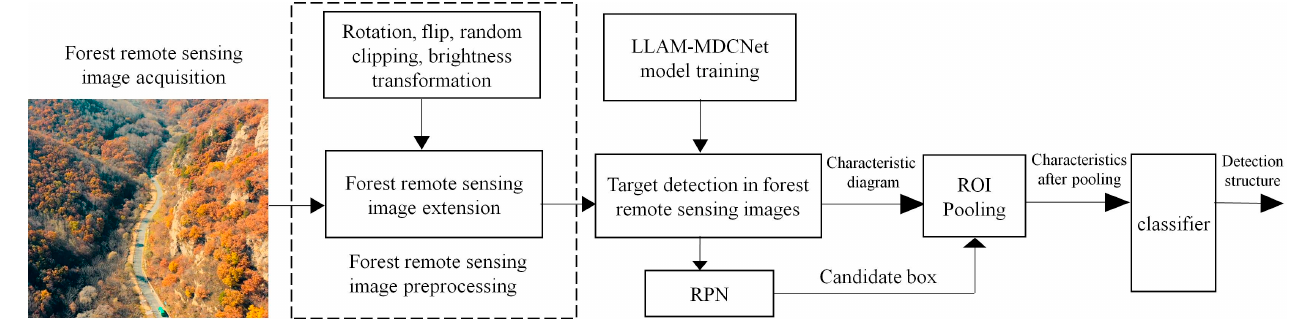
Figure 2. The workflow diagram of LLAM-MDCNet.